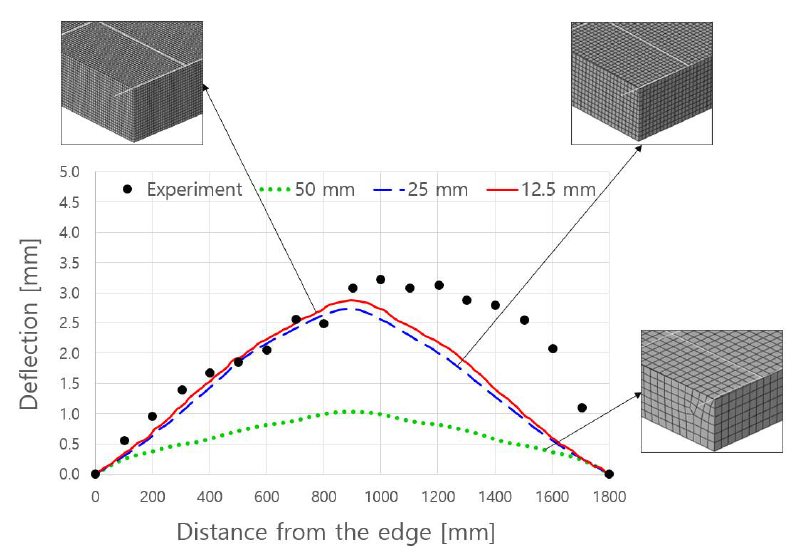
Figure 6. Mesh sensitivity study for steel box model.